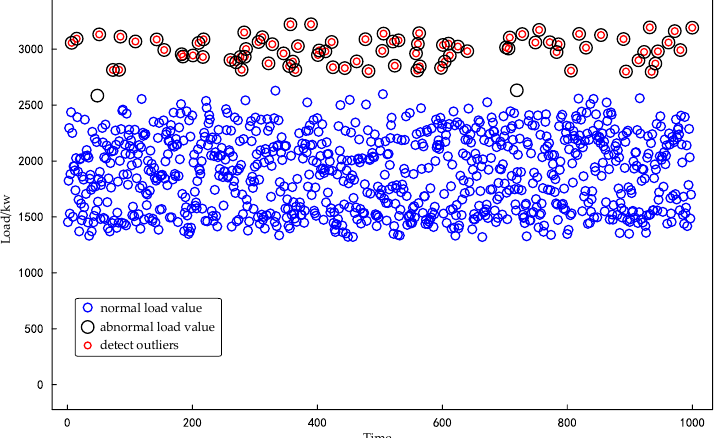
Figure 9. abnormal data detection results. Figure 9. Abnormal data detection